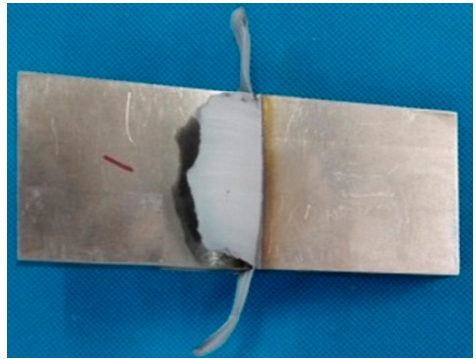
Figure 4. Morphology of the Ti 3 Al joint after LFW.